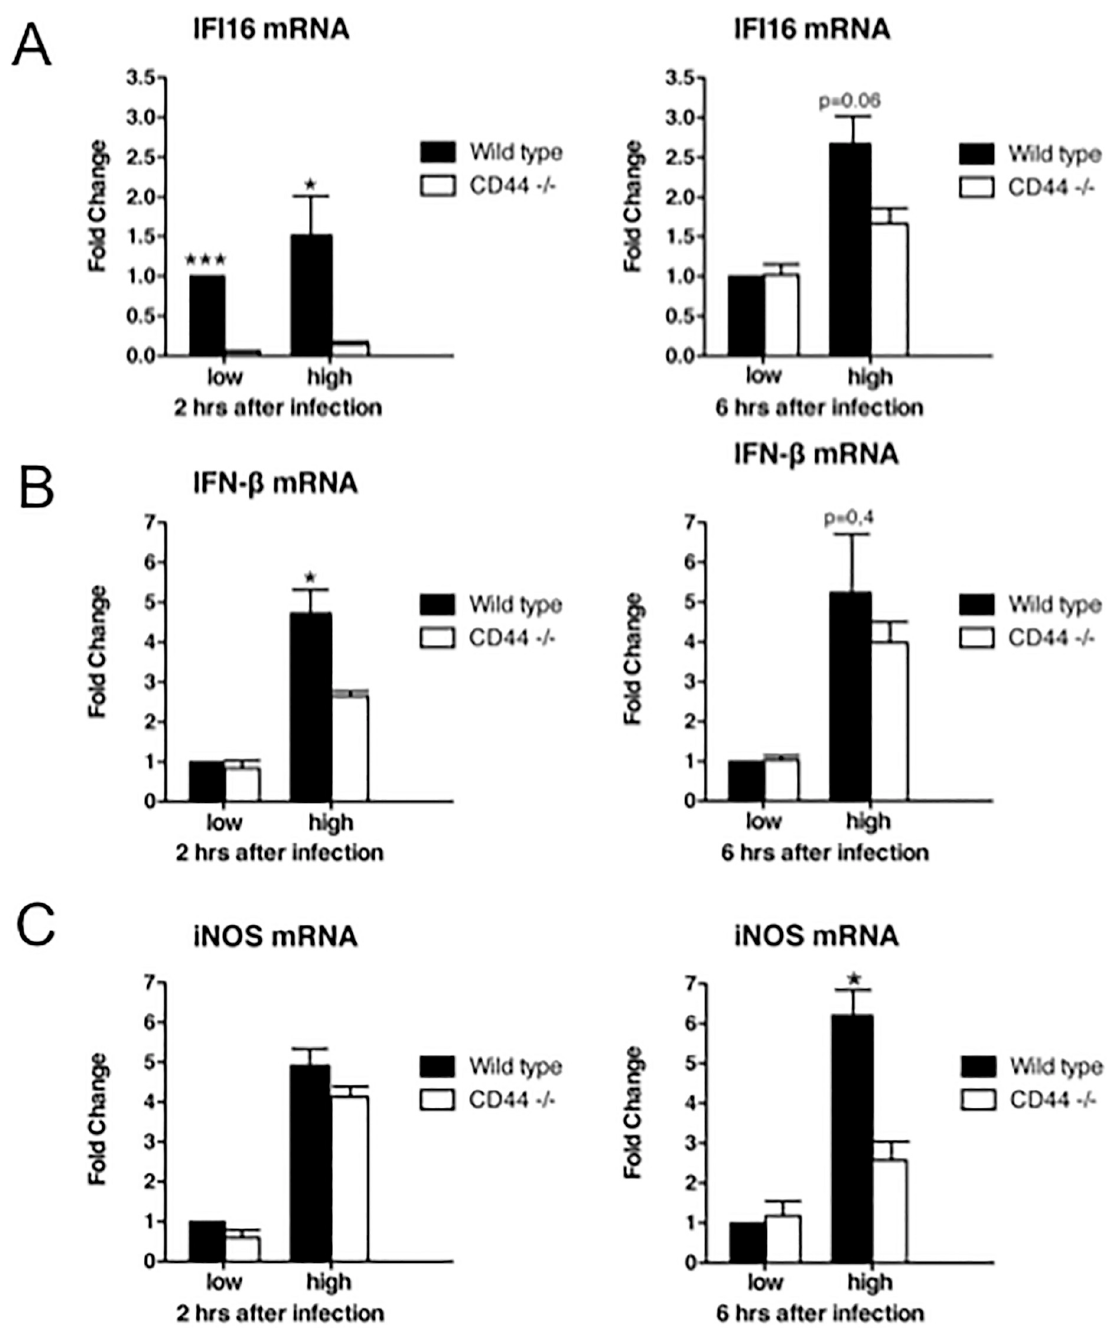
Fig 7. Impaired responses of cd44 -/- bone marrow-derived macrophages. BMDMs were isolated and differentiated from wild type control and knockout animals. L . monocytogenes were grown to an OD of * 2.2. Bacteria were diluted 1:10.000 (low) or 1:5.000 (high) in infection media and introduced to macrophages as described in Materials and Methods. Cells were harvested 2 and 6 h after infection and analysed by RT-qPCR with (A) murine IFI16 oligos (primers 11 and 12, Table 1) or (B) IFN- β oligos (primers 13 and 14, Table 1) or (C) iNOS oligos (primers 15 and 16, Table 1). Experiments were done in triplicates. For statistics see Materials and methods.